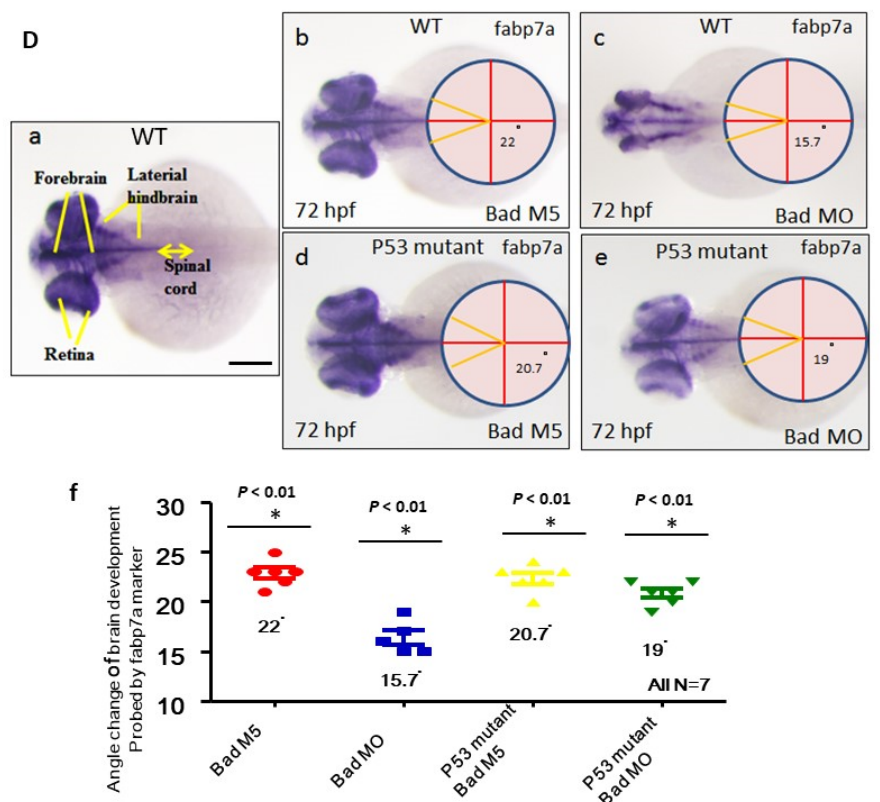
Figure 6. Brain development was directly restored during blockage of the p53-mediated stress signaling transition in p53 mutant lines with Bad knockdown. ( A ) Brain developmental marker pax2a expression in an in situ hybridization assay showing normal expression in the p53 mutant line (panels c and d) compared to the wild-type group (panels Aa – Ae ) during Bad knockdown at 24 hpf. Defective marker expression was counted and is shown in panel ( Ae ). Scale bar = 100 µ m. ( B , C ) The canopy-fused EGFP line was used to monitor brain development directly in the p53 mutant line during loss-of-Bad expression at 48 hpf. The midbrain/hindbrain boundary is indicated by an arrow. ( C ) Blockage of the p53-mediated stress signaling transition can restore brain development (indicated by arrows) compared to the wild-type (panels ( Ca , Ce , Ci ) for the Bad-M5 group; panels: ( Cb , Cf , Cj ) for the Bad-MO group) and p53 mutant lines (panels ( Cc , Cg , Ck , Cm ) for the Bad-M5 group; panels ( Cd , Ch , Cl , Cn ) for the Bad-MO group) at 48 hpf during Bad knockdown. Green fluorescence intensity was recorded and is shown in ( Co ). Scale bar = 200 µ m. ( D ) Brain development was probed by used the marker gene fabp7a via in situ hybridization in the wild-type and p53 mutant lines. Changes in fabp7a marker gene expression at different angles were counted and are shown in ( Df ). Scale bar = 100 µ m. All N = 7. All data were analyzed using either paired or